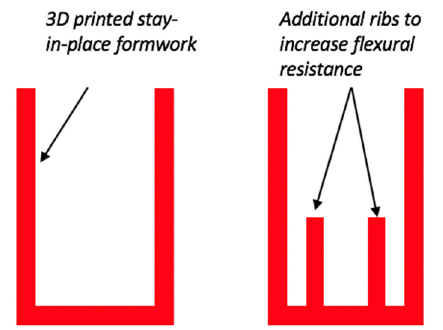
Figure 3. Concept of a 3D printed stay ‐ in ‐ place formwork which acts as reinforcement, after [23].